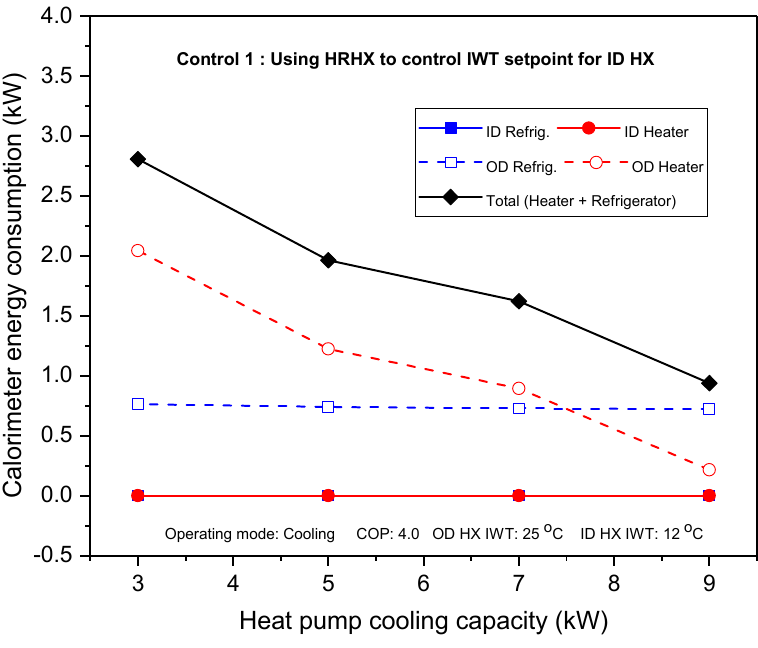
Figure 11. Calorimeter energy consumption with variation in heat pump cooling capacity for control (1).